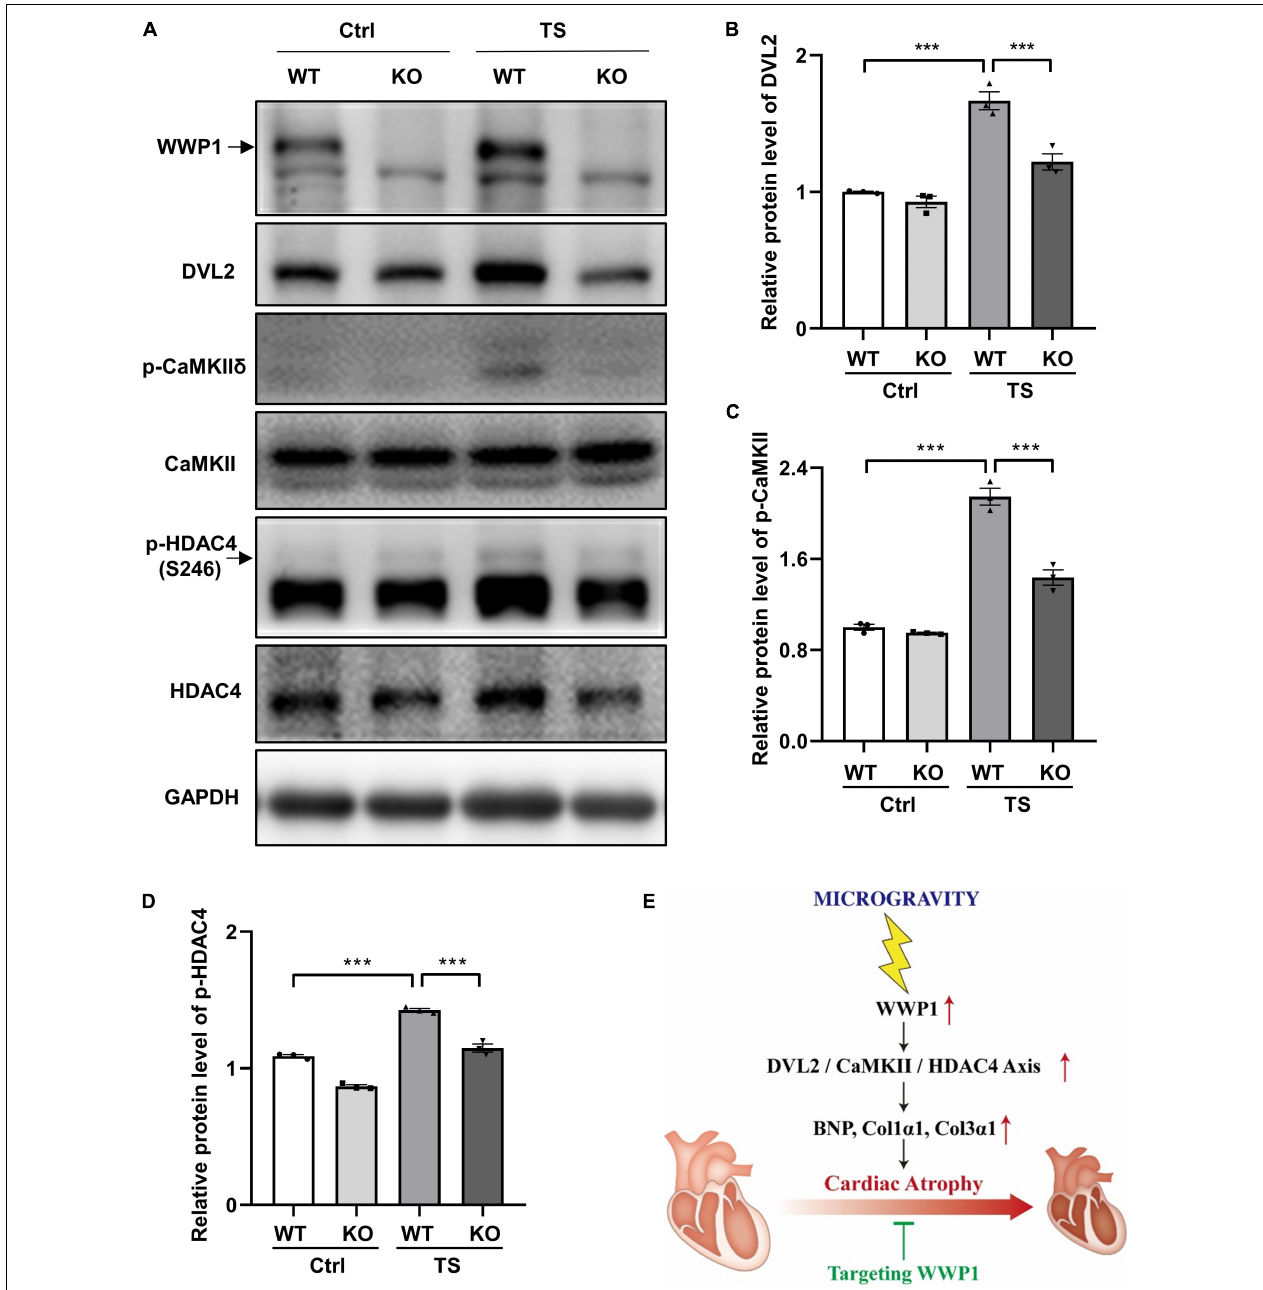
FIGURE 6 | WW domain-containing E3 ubiquitin protein ligase 1 knockout inhibits DVL2/CaMKII/HDAC4 signal in mice heart after simulated microgravity. (A) Representative western blots for WWP1, DVL2, and CaMKII δ and phosphorylation at Thr287 and HDAC4 and phosphorylation at Ser246 in the hearts from WT and WWP1 KO mice after 6 weeks of tail suspension. GAPDH levels served as a loading control. (B–D) Quantification analysis of corresponding protein in (A) . (E) Model of WWP1 function in simulated microgravity-induced cardiac remodeling signaling. Data represent the means ± SEM. *** P < 0.001. WWP1, WW-domain containing E3 ubiquitin protein ligase 1; DVL2, disheveled segment polarity protein 2; CaMKII, calcium/calmodulin-dependent protein kinase II; HDAC4, histone deacetylase 4; TS, tail